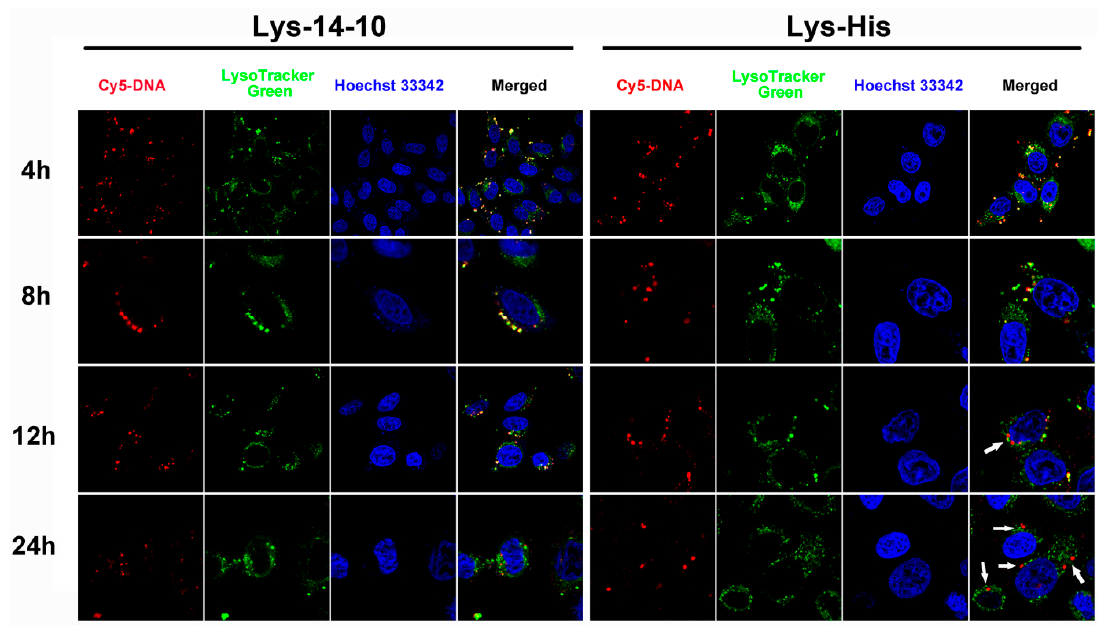
Figure 6. Confocal laser scanning microscopy (CLSM) images of HeLa cells transfected with Cy5-labelled DNA by Lys-14-10 and Lys-His at the optimal transfection N/P ratio at different times. For each row, from left to right: Cy5-labelled pGL-3 DNA (red); lysosomes and acidic late endosomes stained by LysoTracker green (green); cell nucleus stained by Hoechst 33342 (blue) and merged image.